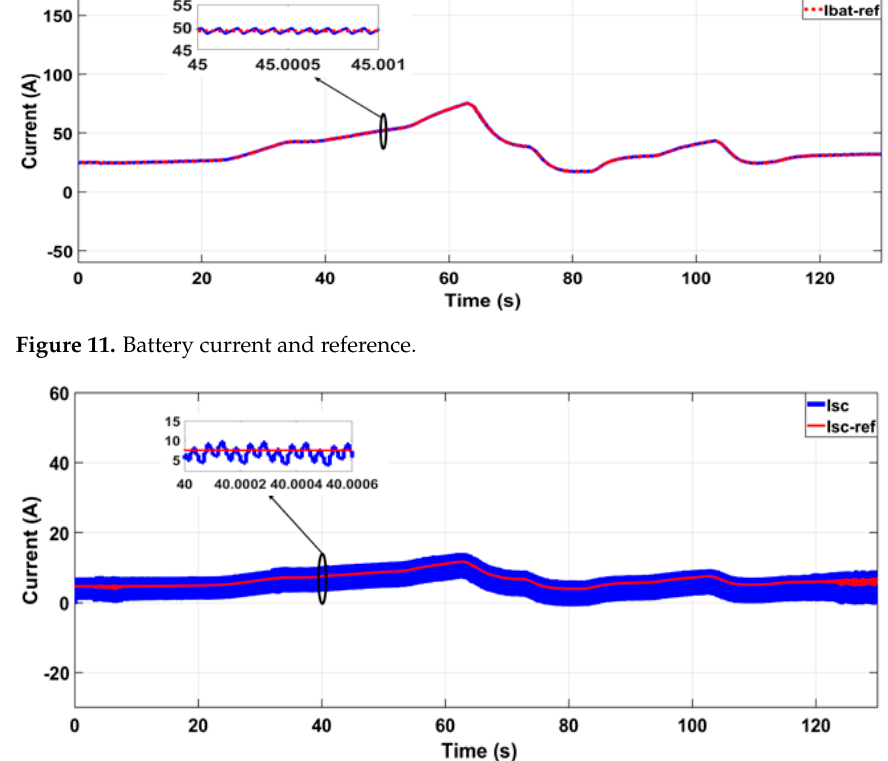
Figure 12. Supercapacitor current and reference.